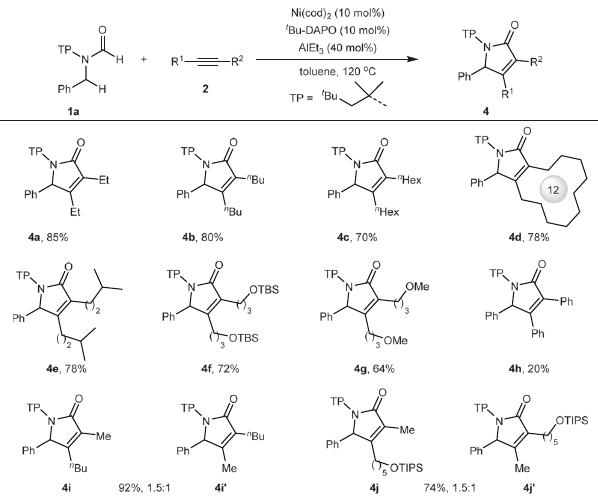
Fig.3|Scopeofalkynes. Reactionconditions: 1a (0.2mmol), 2 (0.6mmol),toluene (1.0mL) under N 2 for 2h; yield of isolated products. n Hex= n -hexyl. TBS= tert -